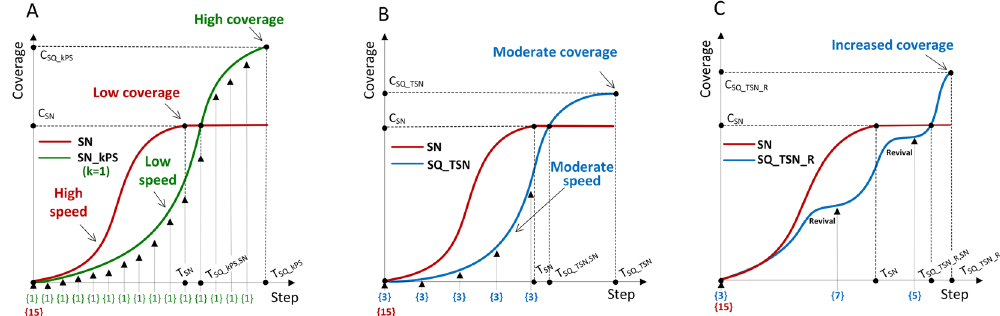
Figure 1. ( A ) k per stage sequential seeding strategy (SQ_kPS) with k = 1 compared with the single stage approach (SN). ( B ) Sequential strategy based on the reference time (SQ_TSN) compared with the single stage approach (SN). ( C ) Sequential strategy with revival mode (SQ_TSN_R) compared with the single stage approach